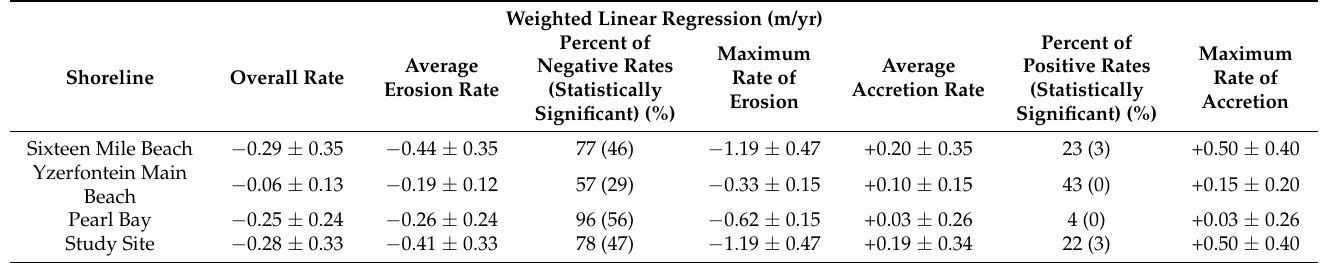
Table 9. Summary of Weighted Regression Rates of change (WRR) to the study site shoreline and its three beaches with erosional rates as negative and accretional rates as